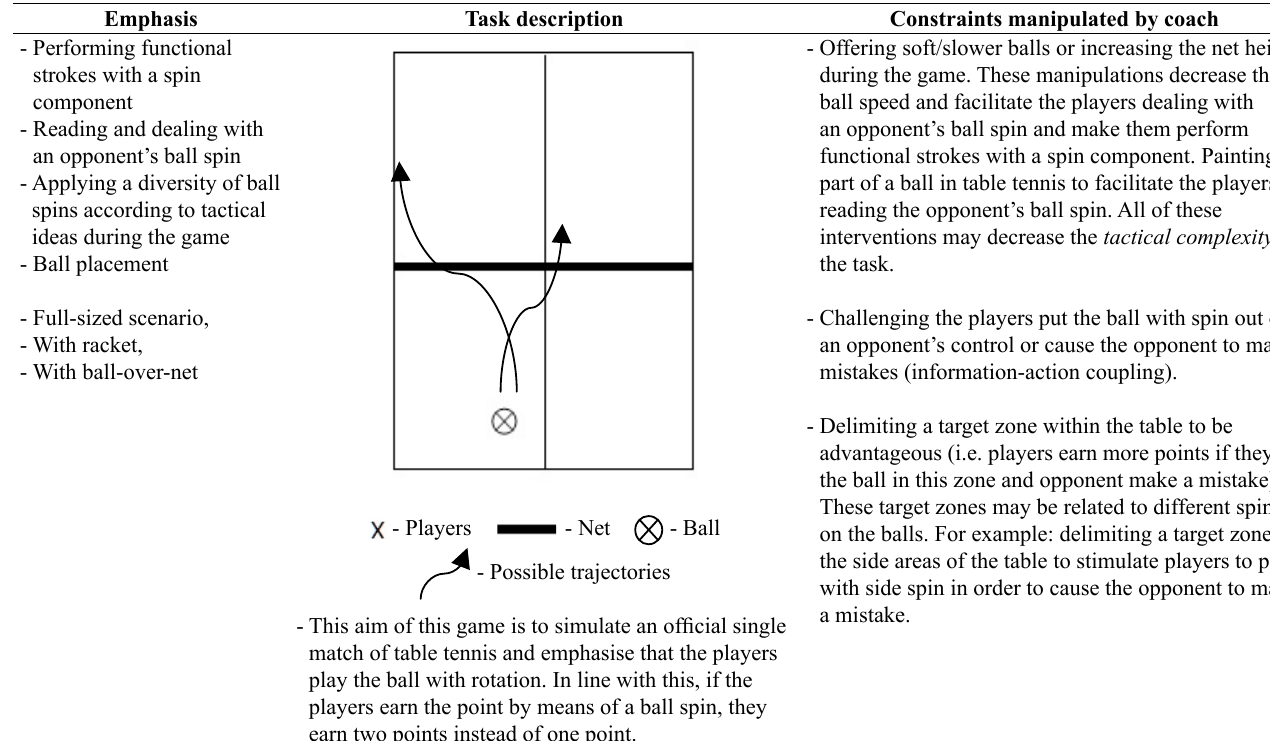
youth table tennis players. The Netherlands: Radboud University Medical Center and Saxion University of Applied Sciences; 2016.